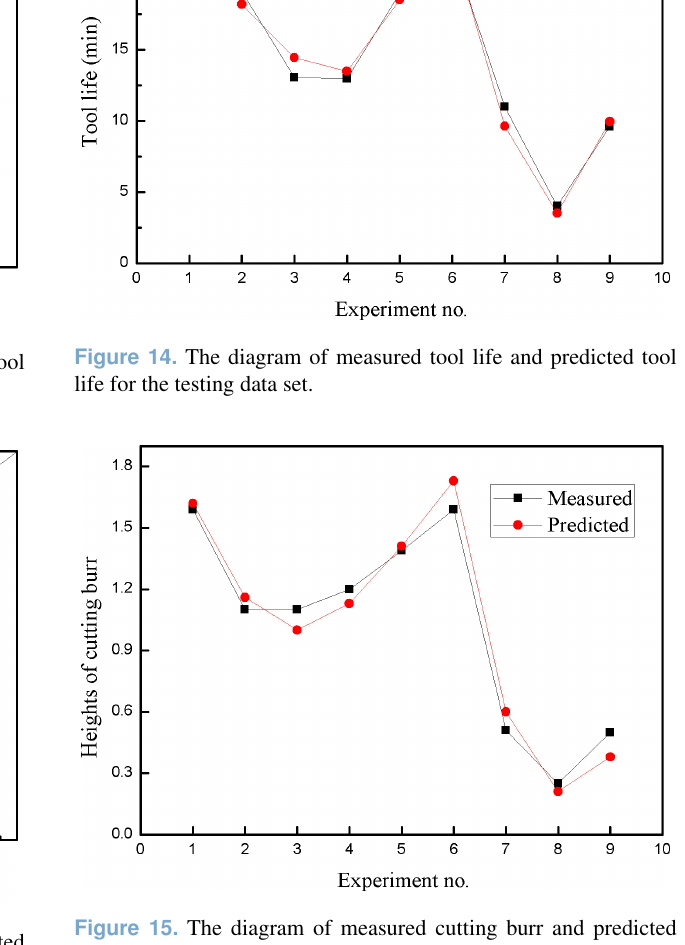
Figure 13. Scatter diagram of measured cutting burr and predicted cutting burr for the testing data set.